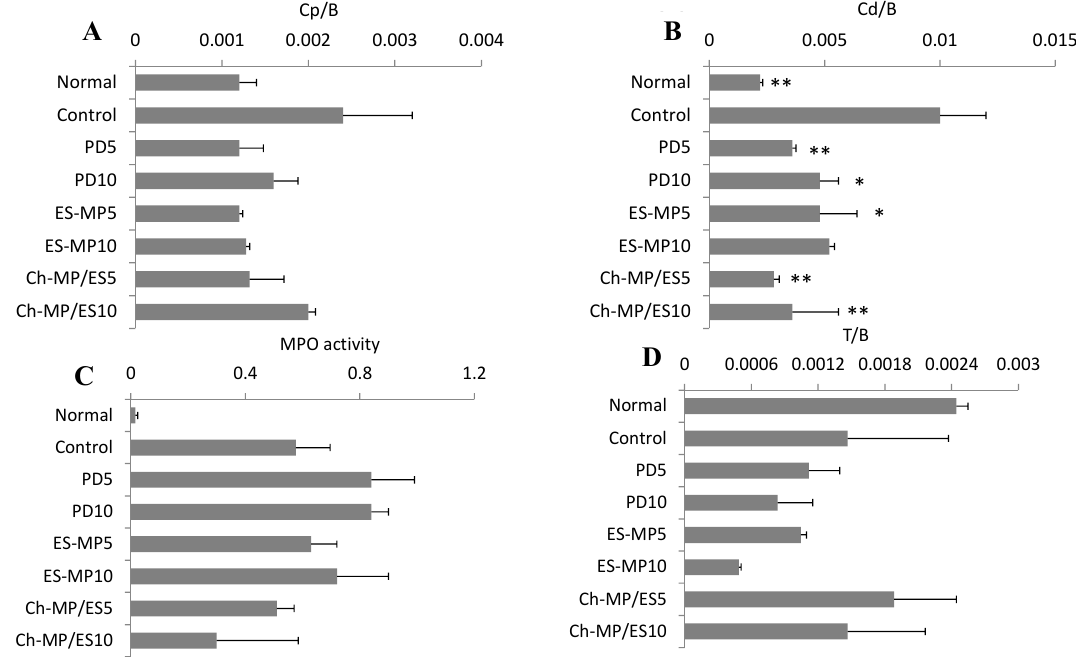
Figure 3. Cp/B, Cd/B, MPO activity and T/B after oral administration of each formulation in rats with TNBS-induced colitis. Efficacy was evaluated from ( A ) Cp/B values; ( B ) Cd/B values and ( C ) MPO activity; Toxic side effect was investigated from ( D ) T/B values. Normal (healthy), Control (non-treated), PD5 (5 mg PD/kg × 3 times (every 24 h)), PD10 (5 mg PD/kg × 6 times (every 12 h)), ES-MP5 (5 mg PD eq/kg × 3 times (every 24 h)), ES-MP10 (5 mg PD eq/kg × 6 times (every 12 h)), Ch-MP/ES5 (5 mg PD eq/kg × 3 times (every 24 h)), and Ch-MP/ES10 (5 mg PD eq/kg × 6 times (every 12 h)) were investigated. The results are described as the mean ± S.E. ( n = 3). * p < 0.05, ** p < 0.01 vs. Control.